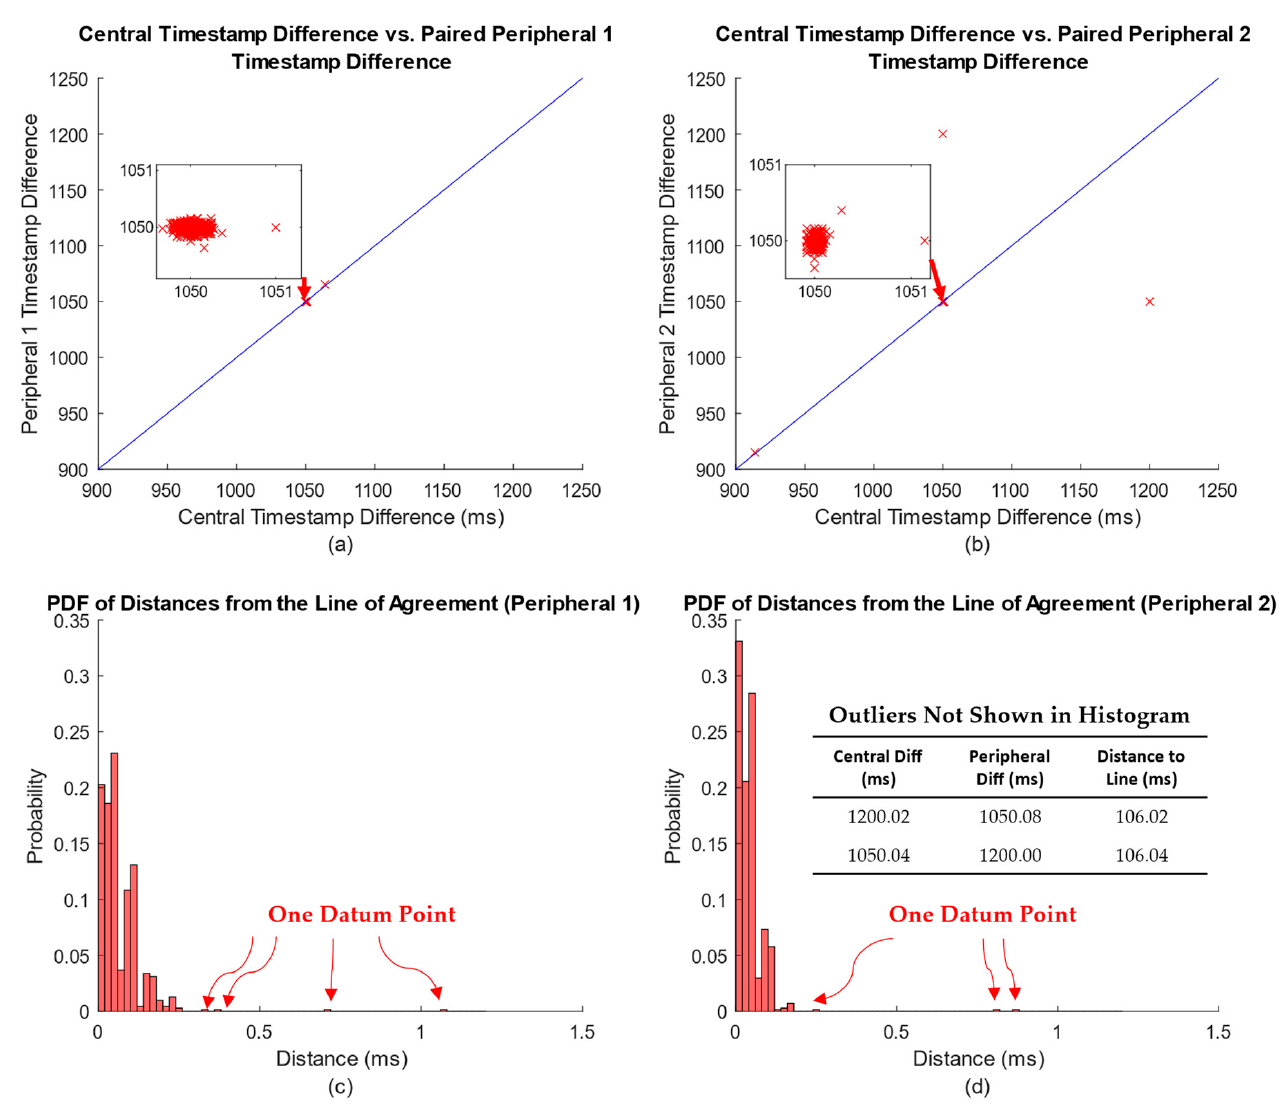
Figure 5. ( a , b ) Cross-plots (one per peripheral node, as labeled) of time differences between successive central node timestamps on the x -axis vs. time differences between paired successive peripheral node timestamps on the y -axis. Inset plots show expanded view of points clustered around the nominal time differences of 1050 ms. Line of agreement drawn in each cross-plot. ( c , d ) Corresponding histograms of the distances from each x–y timestamp location and the closest point on the line of agreement. Scales differ in all plots.